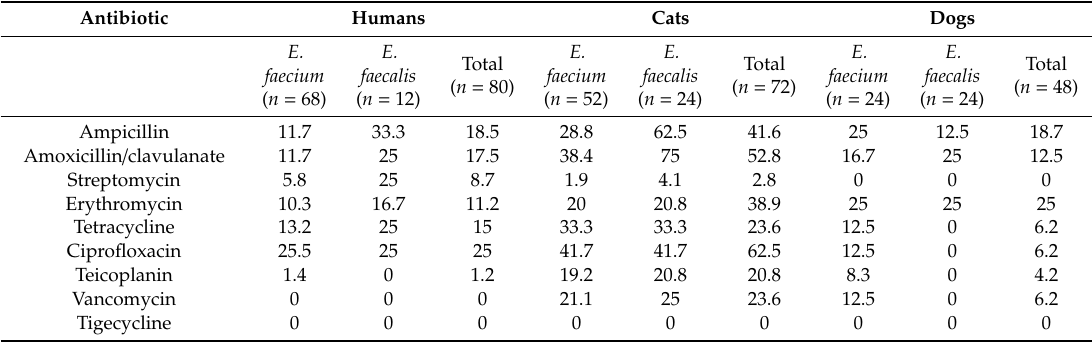
Table 2. Percentages of antimicrobial resistance in enterococci isolated from fecal samples of humans, cats, and